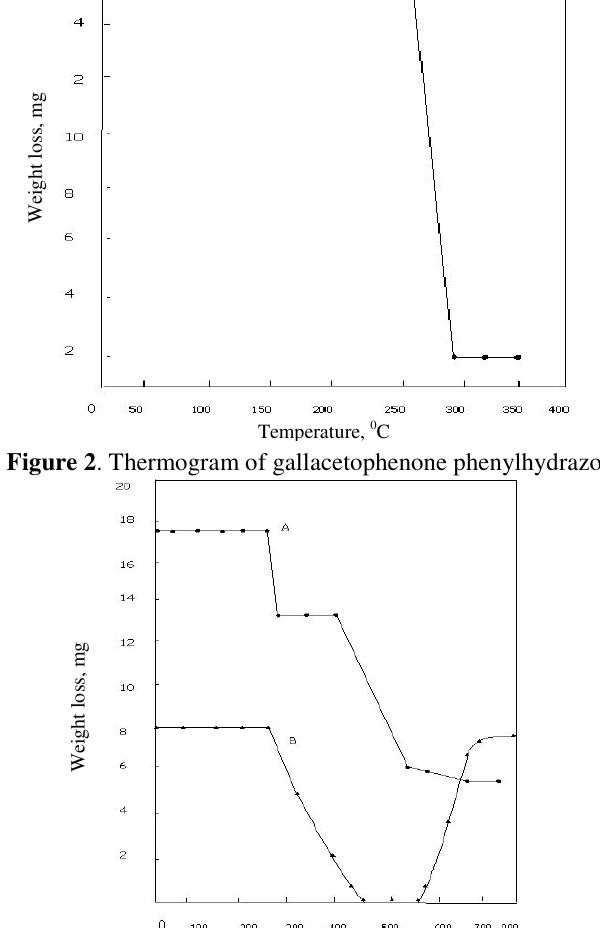
Figure 3 . TG and DTA curves of Bi(III)-GPPH complex; (A) Thermogravimetric curve, (B) Differential Thermal Analysis